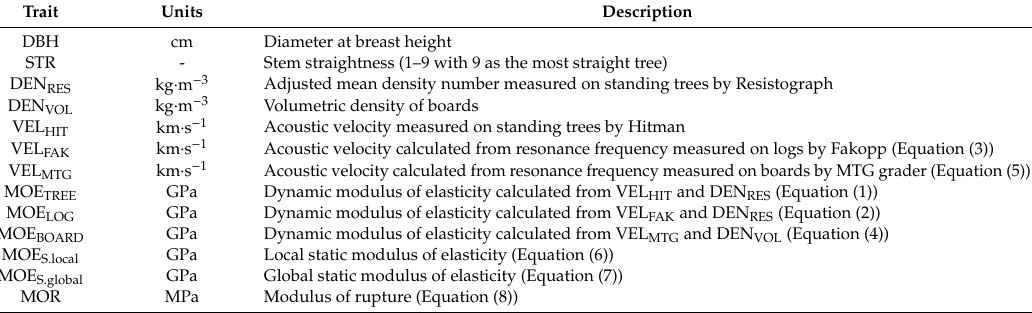
Table 1. List of trait variables assessed for the material at the field age of 38